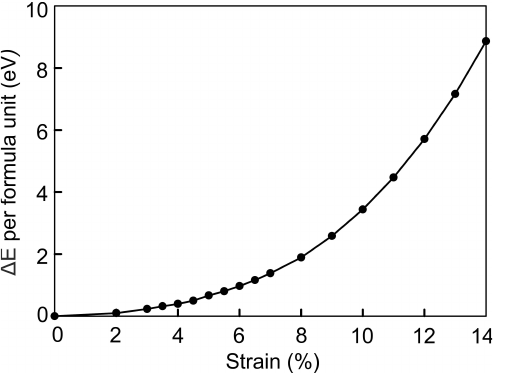
Figure 6. Energetic stability of the compressed Fe 3 Se 4 structure relative to the original structure, ∆ E in eV per Fe 3 Se 4 formula